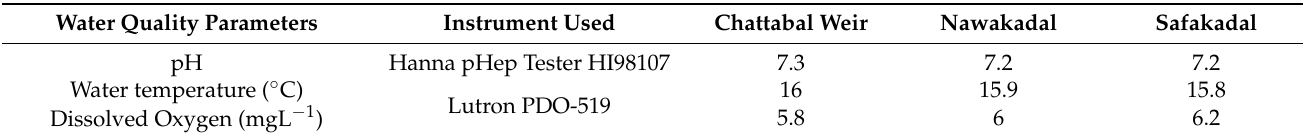
Table 2. Physico-chemical analysis of water samples in the affected tract of the Jhelum